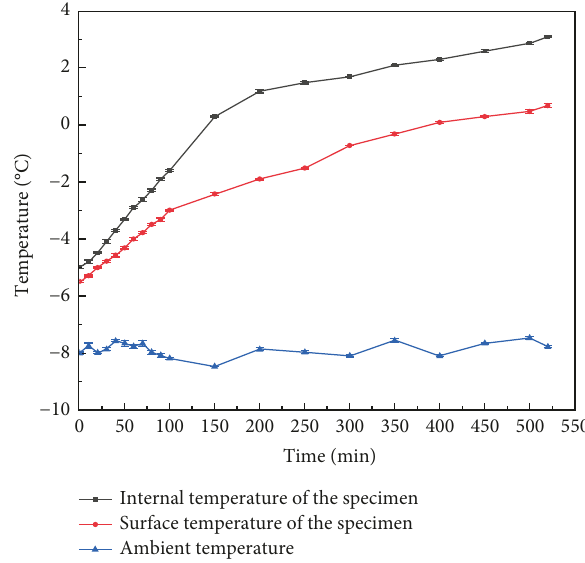
Figure 16: Deicing effect of 0.3% carbon fiber +40% graphite rutting